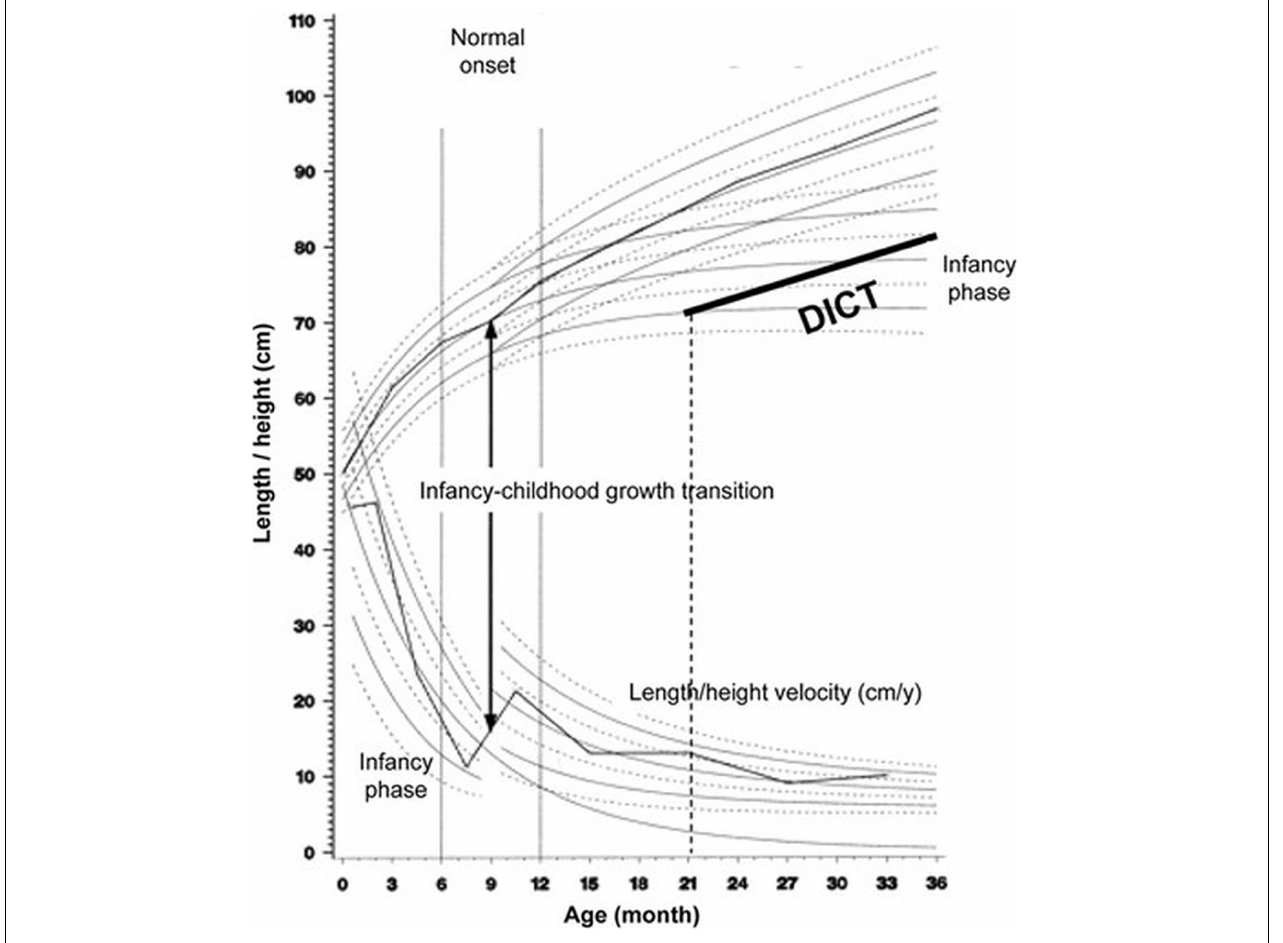
FIGURE 1 | The Infancy, Childhood, and Puberty (ICP) growth model. The ICP growth model divides human growth into three successive and partly superimposed phases that reflect the control mechanisms of the growth process. The infancy phase of the ICP model begins at mid-gestation and tails off at 2–3 y of age. The childhood growth phase sets on in affluent Western countries between 6 and 12 month of age, and when the Infancy to Childhood transition age is delayed (DICT) beyond age 12 month (21 month for this hypothetical child), it has a permanent effect on final adult height. Adapted with permission from Hochberg and Albertsson-Wikland